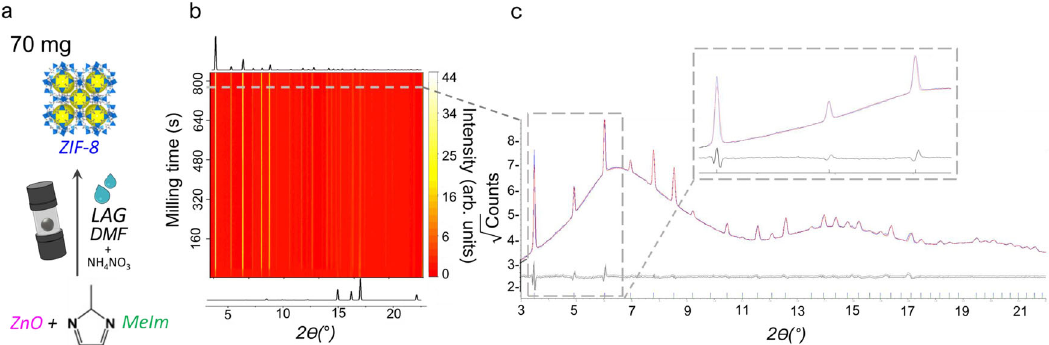
Fig. 4 TRIS-XRPD for Reaction II, the mechanochemical syntheses of ZIF-8 with a loading of 70 mg. a A 0.1 equivalent of NH 4 NO 3 is added to 1 equivalent of ZnO and 2 equivalents of 2-methylimidazole (MeIm) under ball mill liquid-assisted grinding (LAG) conditions with the addition of 17 µ l DMF. b Heat maps (linear intensity, arb. units) of TRIS-XRPD with empirical background-subtracted data for Reaction II, alongside calculated 1D XRPD patterns for the reagents and the fi nal product (ZIF-8). c Pawley fi t of ZIF-8: calculated pro fi le (red line) against experimental data (blue line) and relative difference pattern trace (grey line). Inset highlights the discrepancy between the model and experimental data in the lower angle part of the diffractogram.